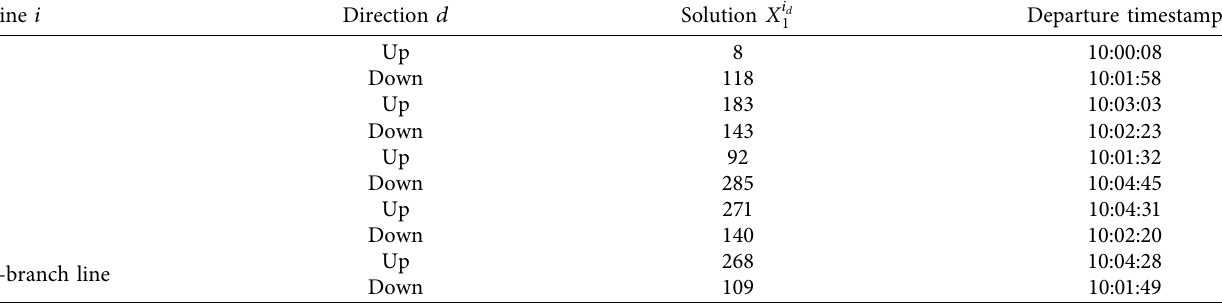
Table 6: Optimal solution for the train network (off-peak period).